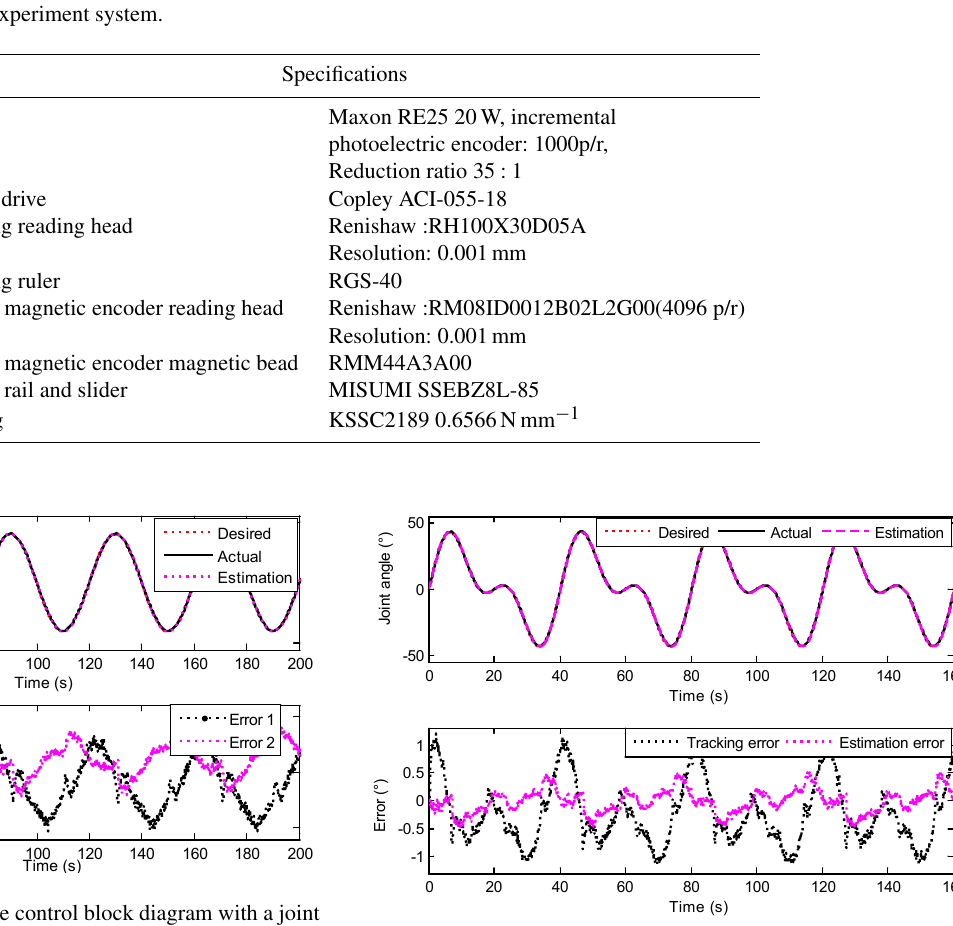
is 0.8355 ◦ , and the minimum of the identification error is − 0.8321 ◦ . These values indicate good accuracy of the joint angle